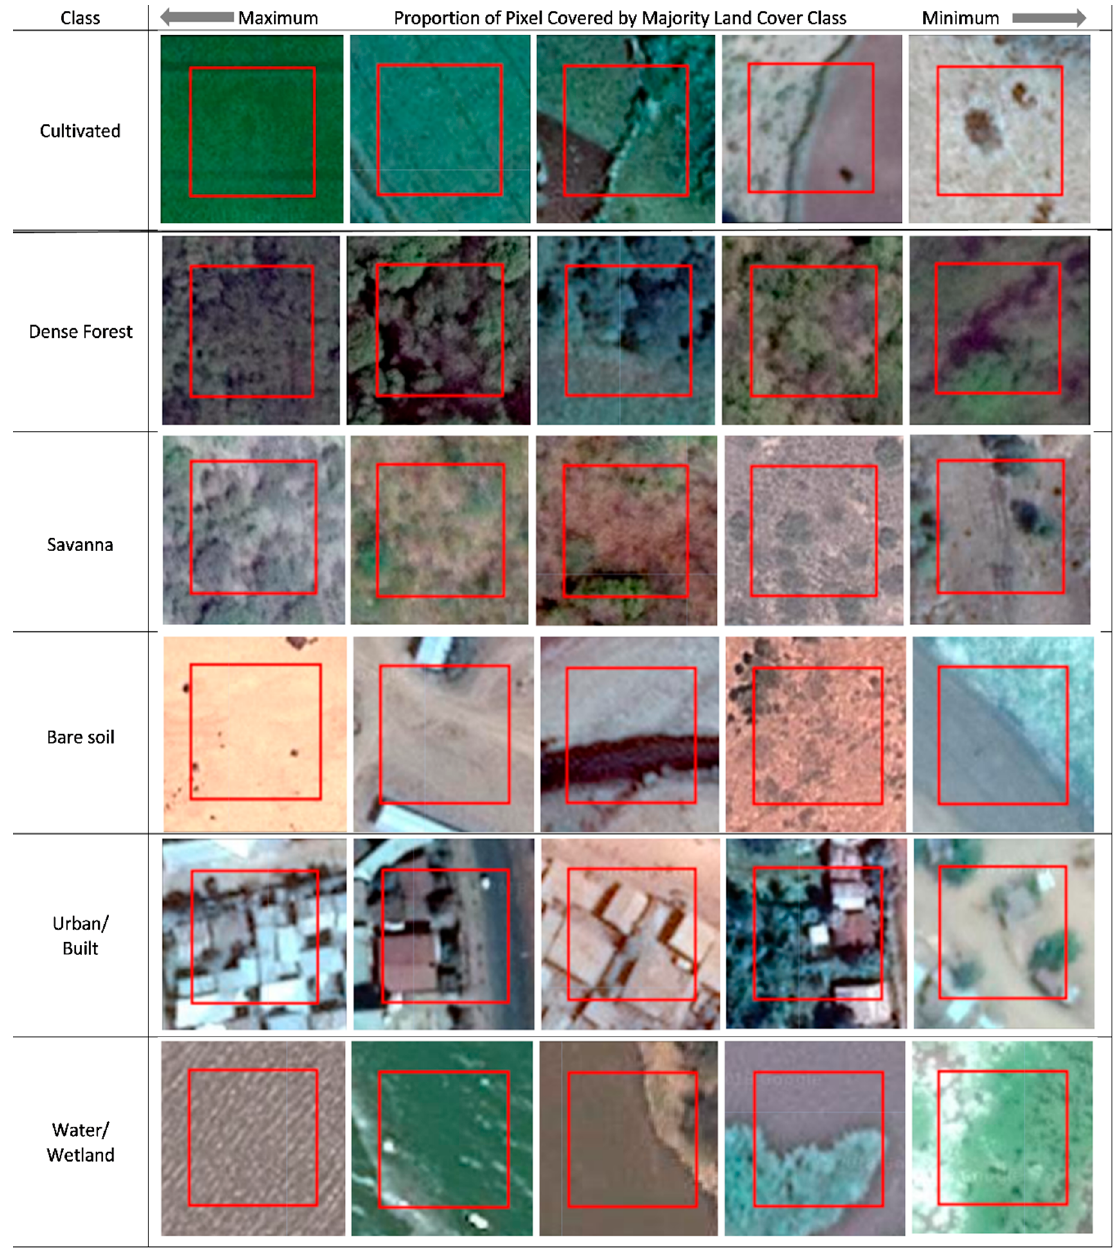
Figure 1. Examples of the target land-cover classes showing the ranges of class distribution, ordered by land-cover proportion cover of a pixel, from maximum cover to minimum cover to still be assigned to the class, from left to right. Red squares show footprints of Landsat pixels.